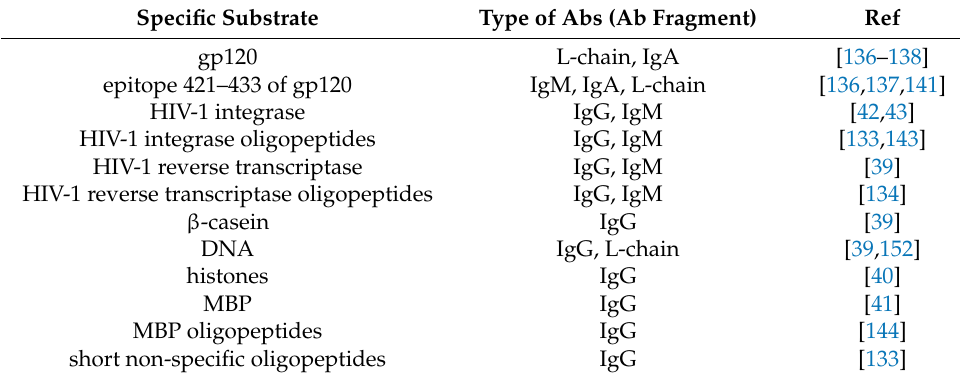
Table 1. The catalytic activity of natural Abs isolated from the blood serum of HIV-1-infected patients, their substrates, and individual